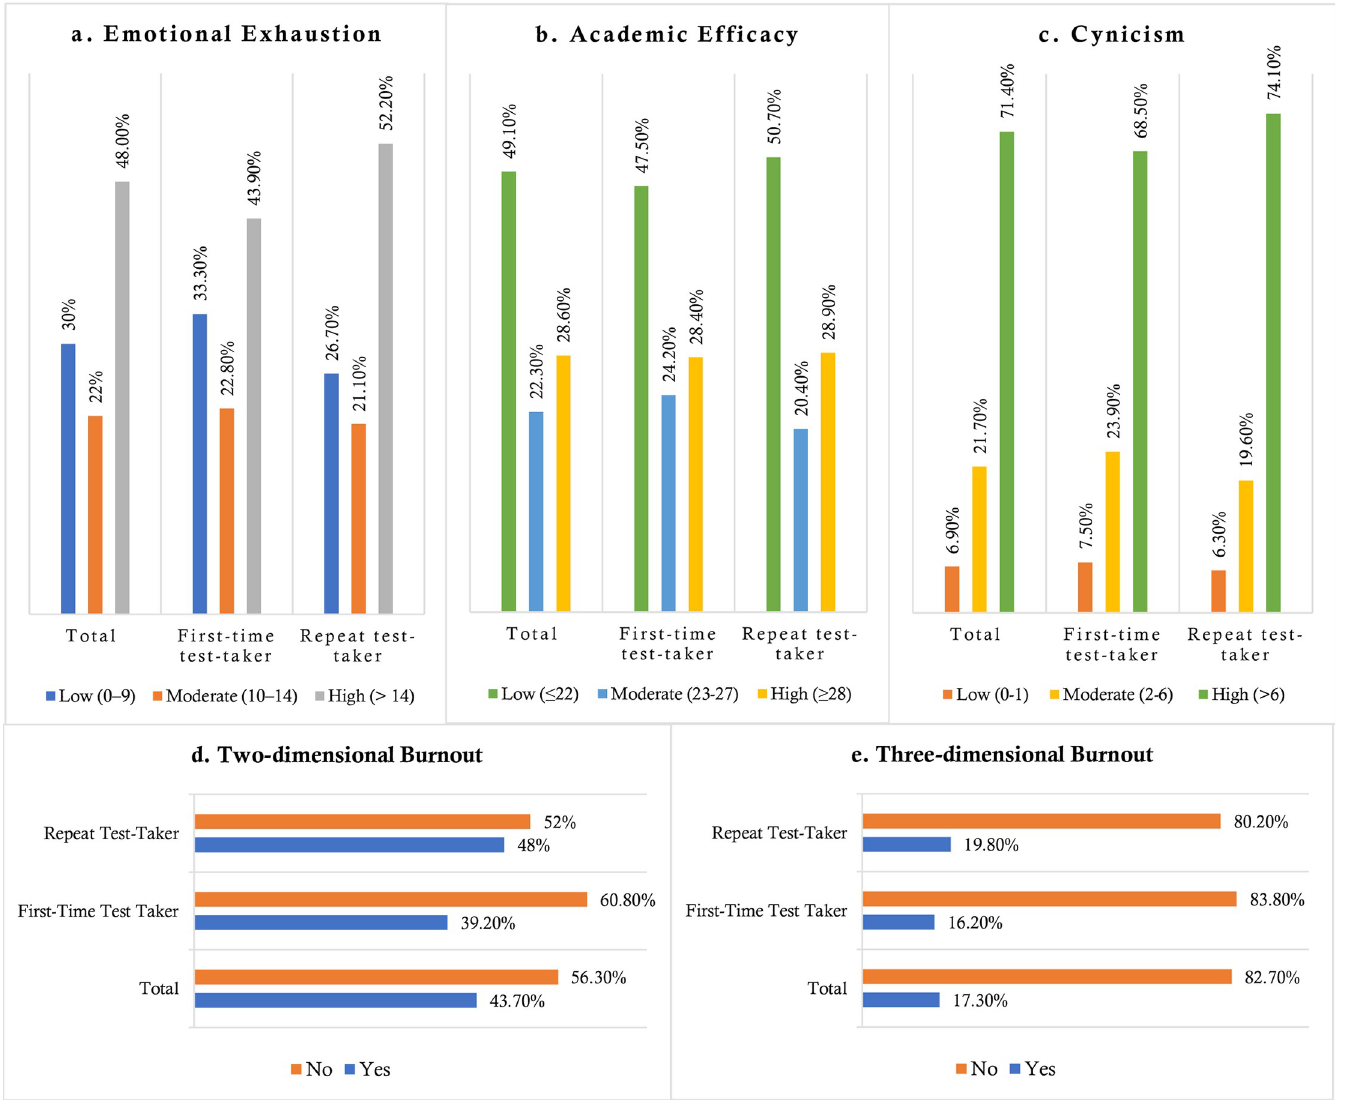
Fig 1. Student status-based distribution of (a) emotional exhaustion, (b) academic efficacy, (c) cynicism, (d) two-dimensional burnout, and (e) three-dimensional